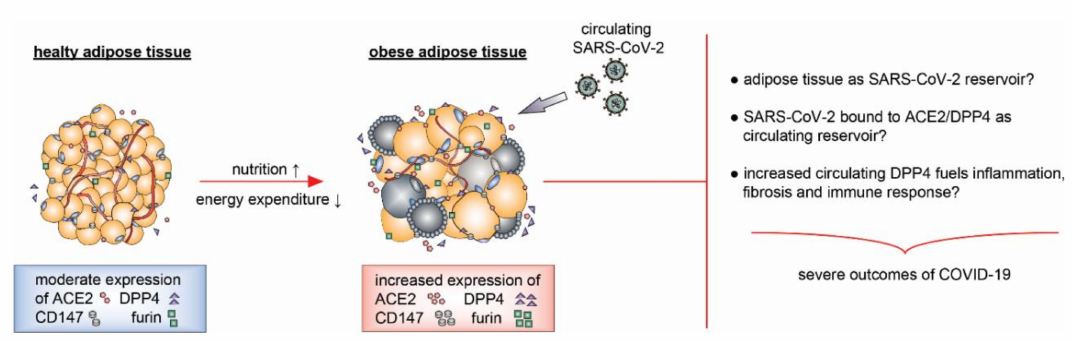
Figure 1. The illustration indicates that adipose tissue expresses the receptors ACE2, DPP4, and CD147, and the protease furin for the SARS-CoV-2 entry. These proteins are upregulated in obese adipose tissues accompanied by an enhanced secretion of ACE2 and DPP4 in the circulation of obese patients. Diseased adipose tissues could be targeted by SARS-CoV-2 and serve as its reservoir, as well as an accelerator reinforcing systemic inflammation and immune response, resulting in severe outcome of COVID-19 in obese